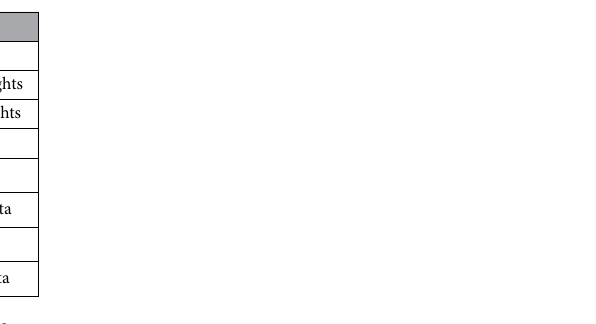
Table 1. Notations in learning by